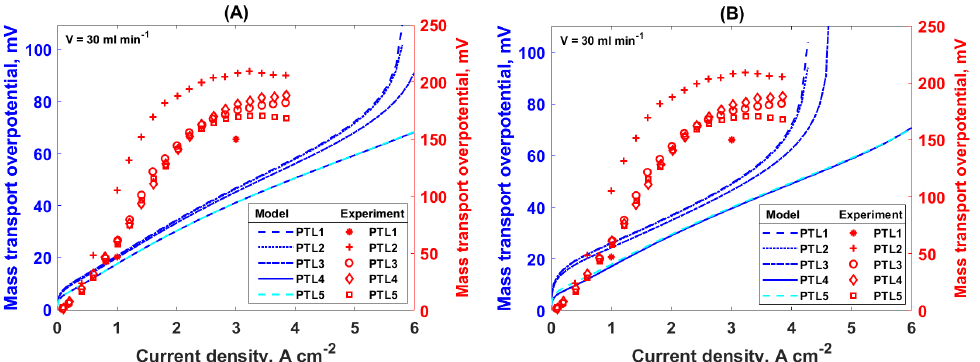
Figure 5. Mass transport overpotential as a function of current density for different PTLs at an inlet flow rate of 30 mL min − 1 obtained with ( A ) LE and ( B ) BCE simulations; lines—model results, symbols—experimental results adopted from